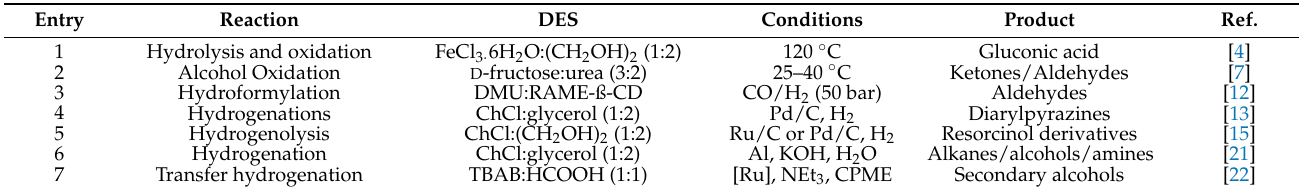
Figure 6. Pd-NPs-catalyzed hydrogenation of unsaturated compounds.